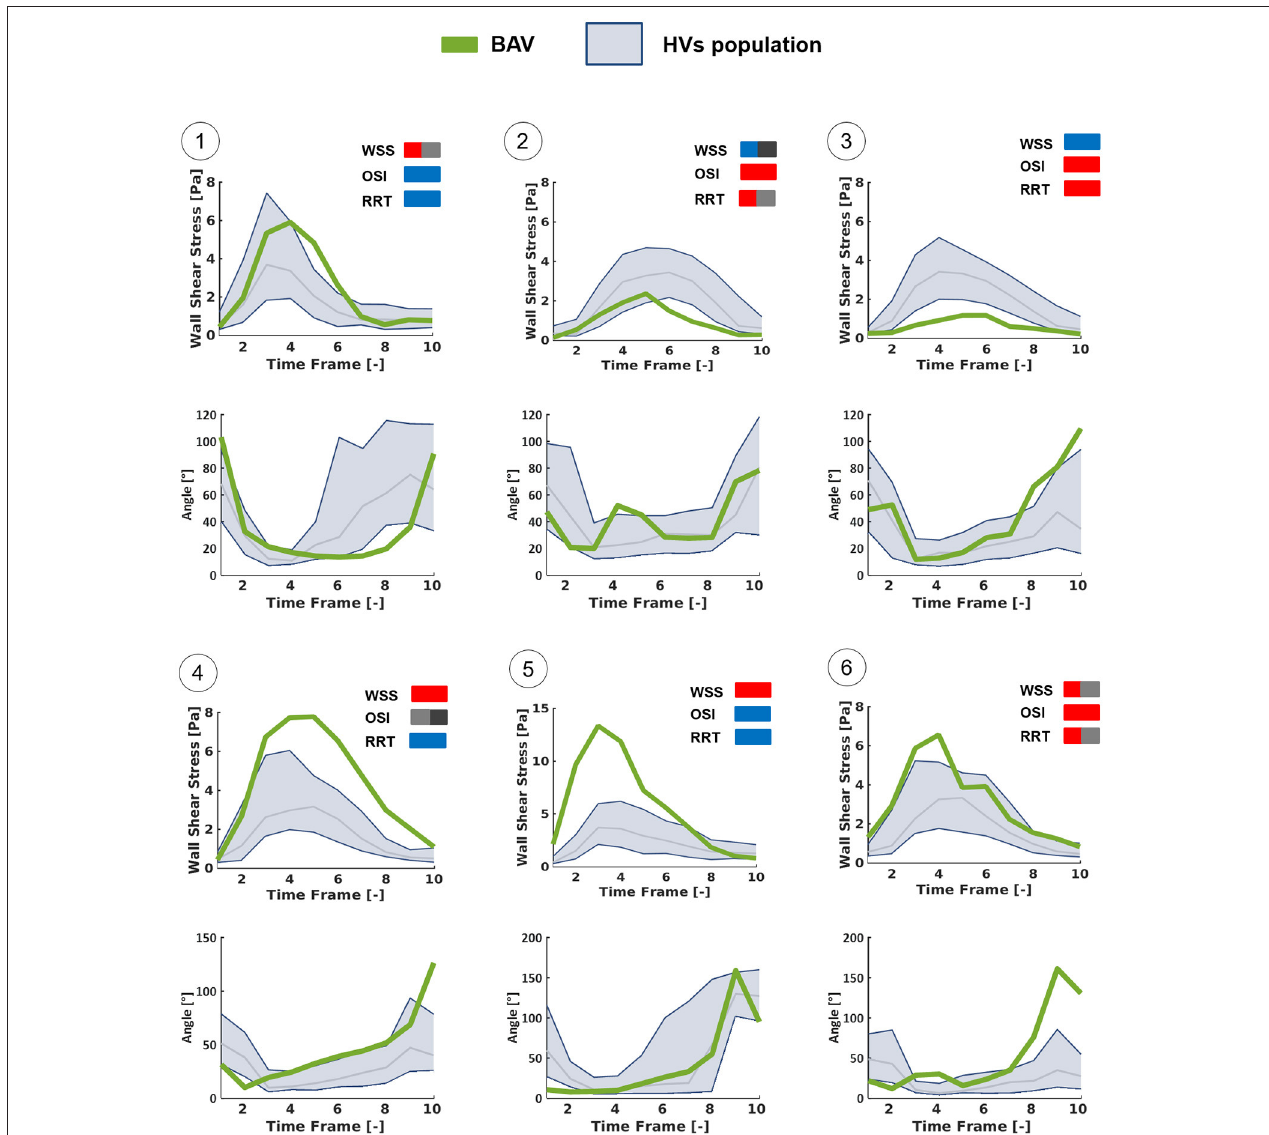
FIGURE 10 | Time-dependent WSS waveforms computed at the selected hot-spots detailed in Figure 9 using the LP method, throughout the systolic phase. Each BAV patient-specific case (green line) was compared with HVs population (blue zone: from 10th to 90th percentiles) in terms of the magnitude of WSS vector and of the angle between it and the axial direction of the